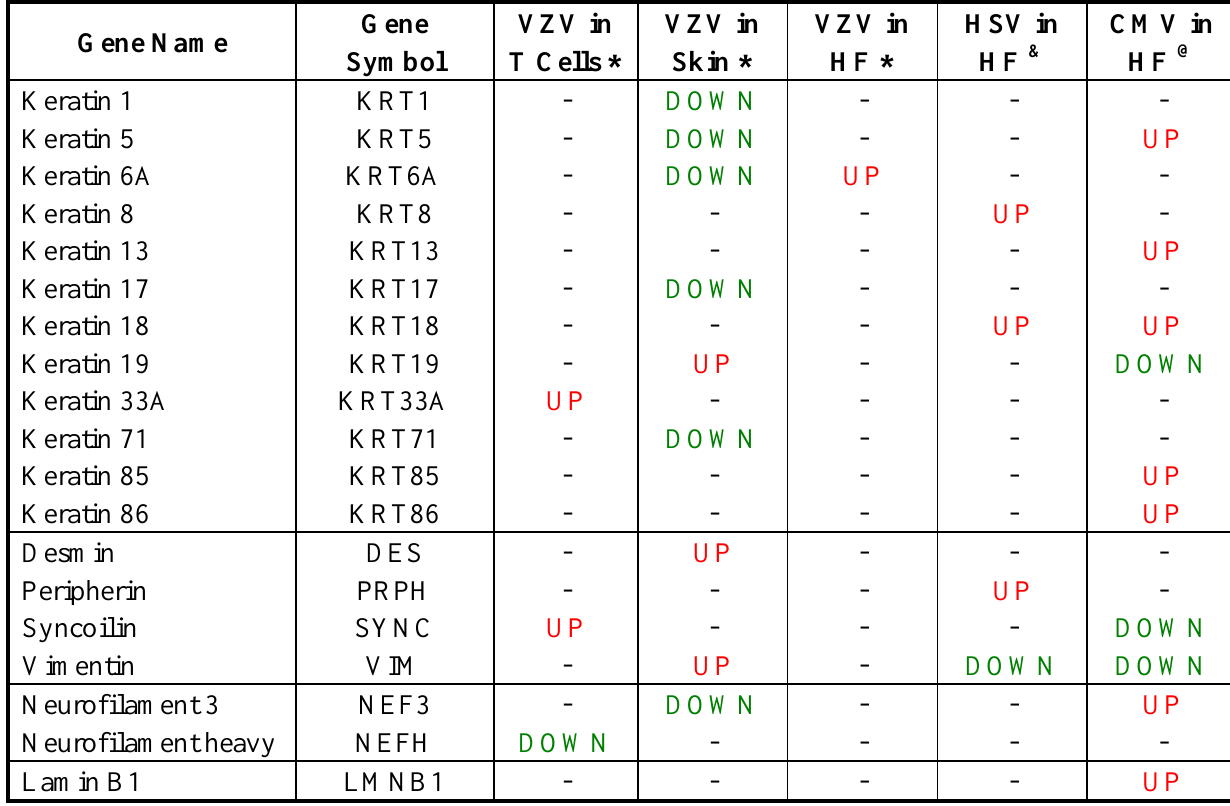
Table 3. Changes in expression levels of IF-encoding genes as reported in functional genomics analyses of infected human tissues and fibroblasts